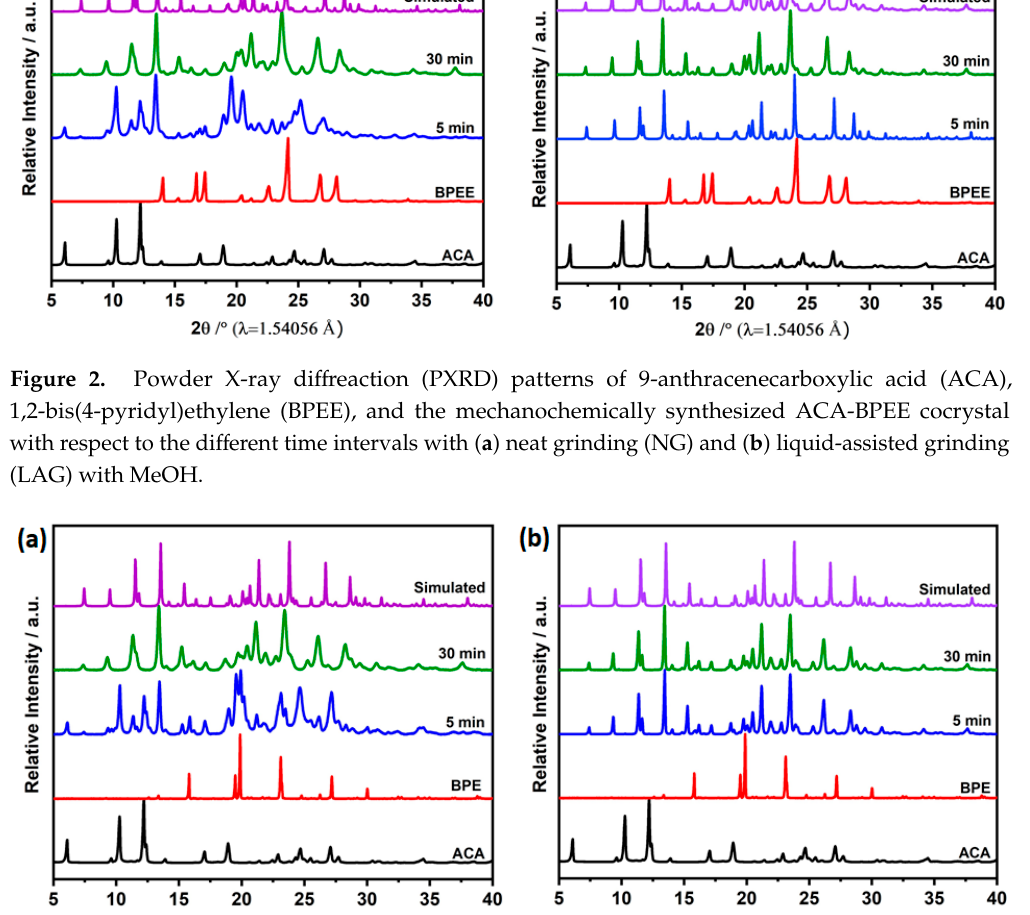
Figure 4. Differential thermal analysis-thermogravimetric (DTA-TG) measurements of ( a ) ACA–BPEE and ( b ) ACA–BPE, respectively. The DTA signals (black) of the cocrystal at the onset 217 °C (for ACA– BPEE) and 190 °C (for ACA–BPE) can be assigned to the melting of the cocrystals, and after that, the complete mass losses are observed in the TG analysis (red).